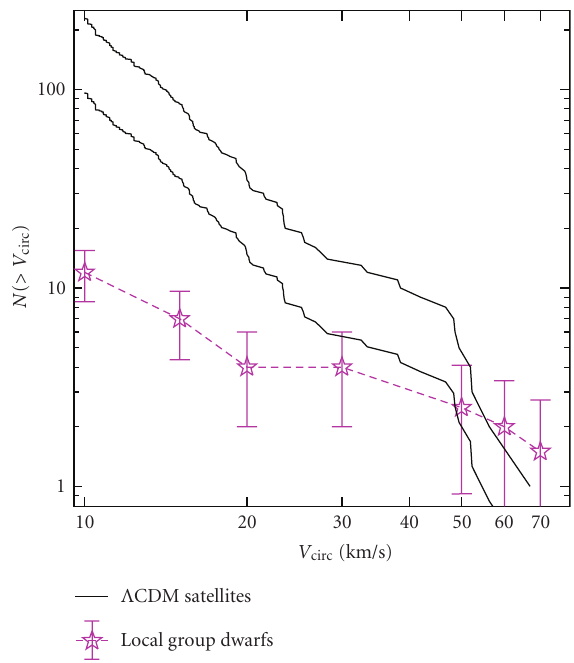
Figure 7: Comparison of the cumulative circular velocity functions, N ( > V max ), of subhalos and dwarf satellites of the Milky Way within the radius of 286 kpc (this radius is chosen to match the maximum distance to observed satellites in the sample and is smaller than the virial radius of the simulated halo, R 337 = 326 kpc). The subhalo VFs are plotted for the host halos with maximum circular velocities of 160 km/s and 208km/s that should bracket the V max of the actual Milky Way halo. The VF for the observed satellites was constructed using circular velocities estimated from the line-of-sight velocity √ 3 σ r (see the discussion in the text for the dispersions as V max = uncertainties of this